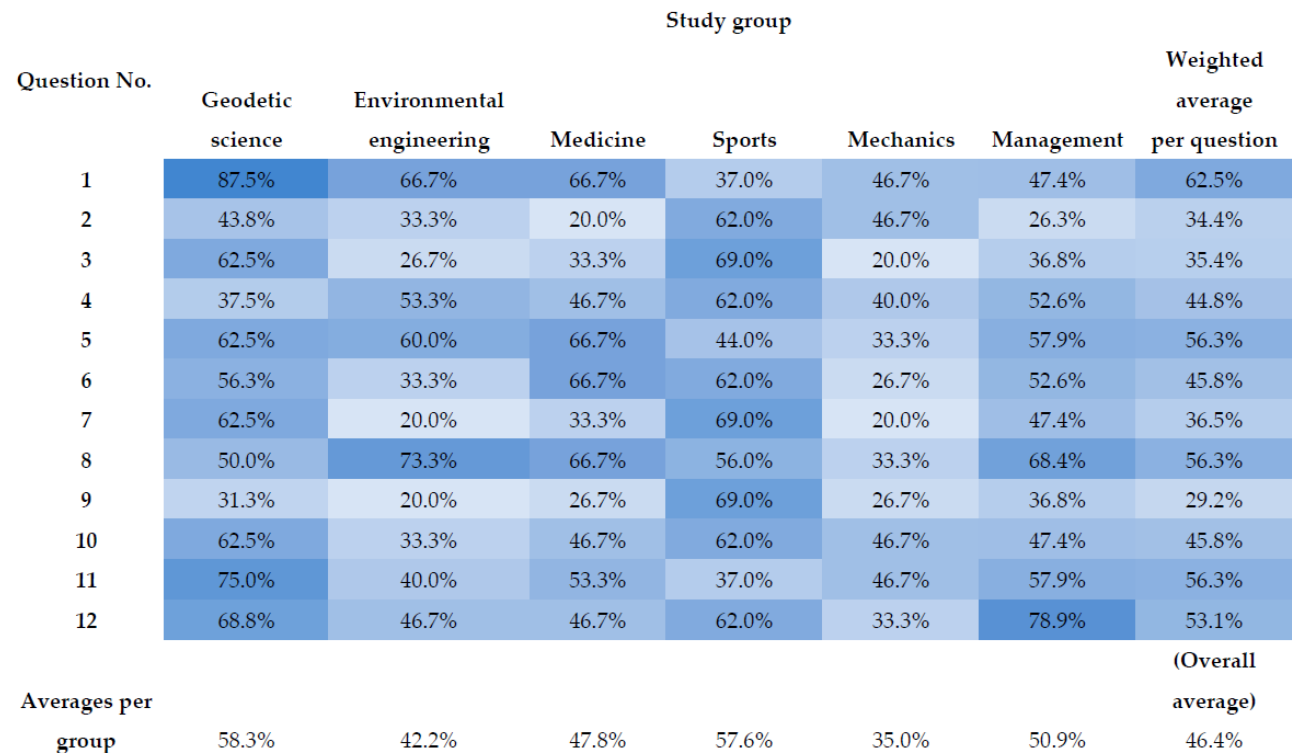
Figure 4. Percentage of correct answers to questions 1 – 12 overall and in study groups.